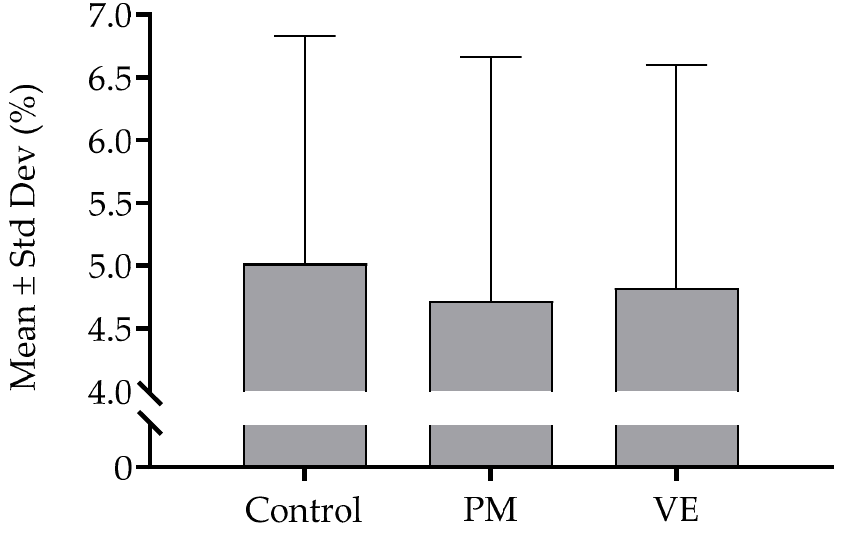
Figure 4. Descriptive statistics for fatigue index (FI) in three conditions (Control, PM—listening of the preferred music, VE—verbal encouragement).